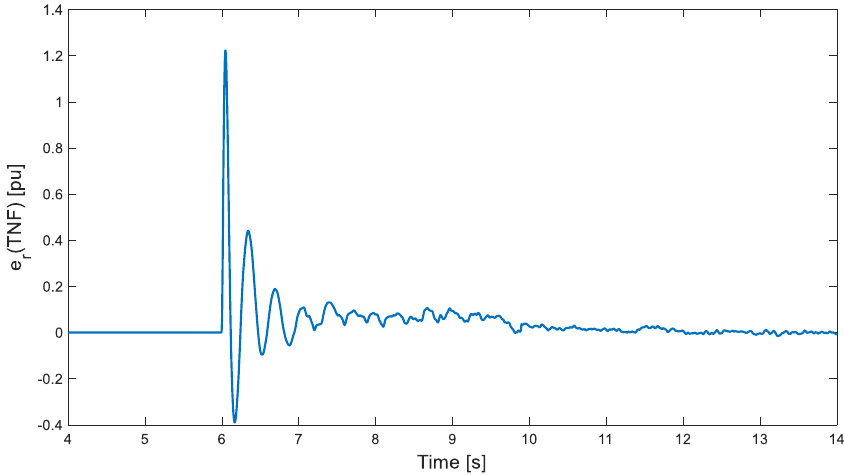
Figure 9. Phase error related to the proposed control scheme shown in Figure 3.